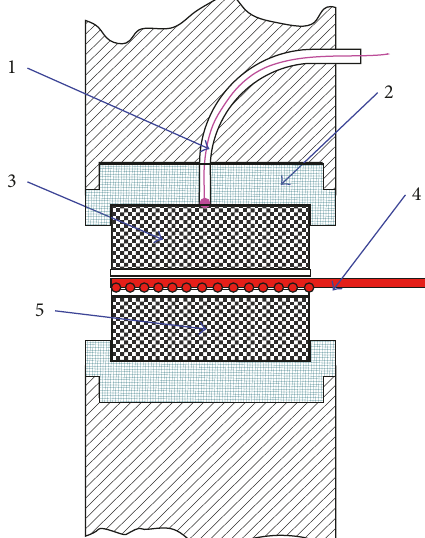
Figure 1: Scheme of placing samples in UTFI-2 installation: 1: thermocouple; 2: heat insulation; 3: examined sample; 4: heating element; 5: auxiliary sample.